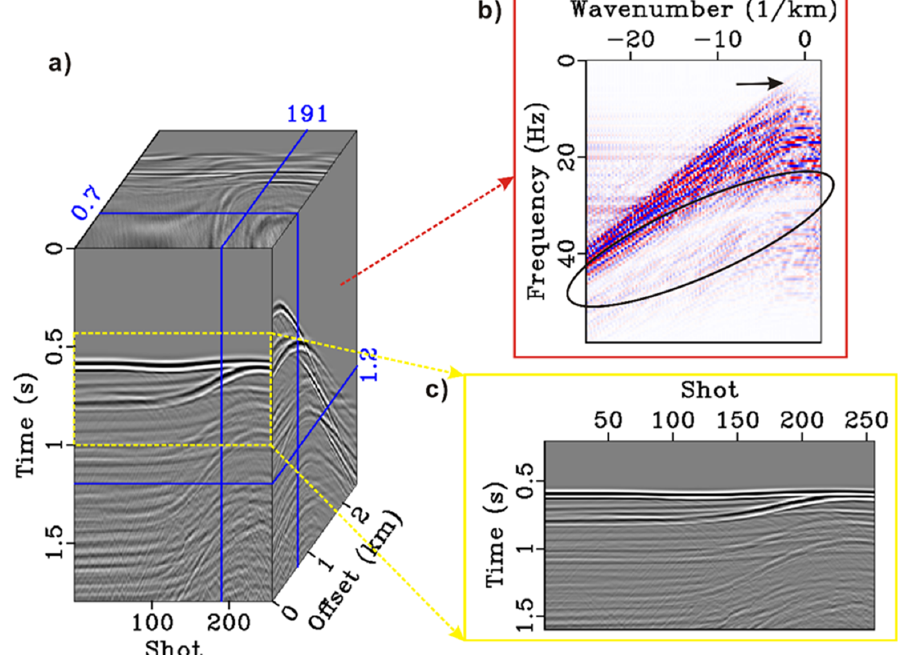
Figure 6. The synthetic data before deghosting. ( a ) 3D data cube including 256 CSGs and 256 COGs. ( b ) f - k spectrum in which the black oval marks the effect of ghost. ( c ) COG wherein the events are similar to the underground interface.